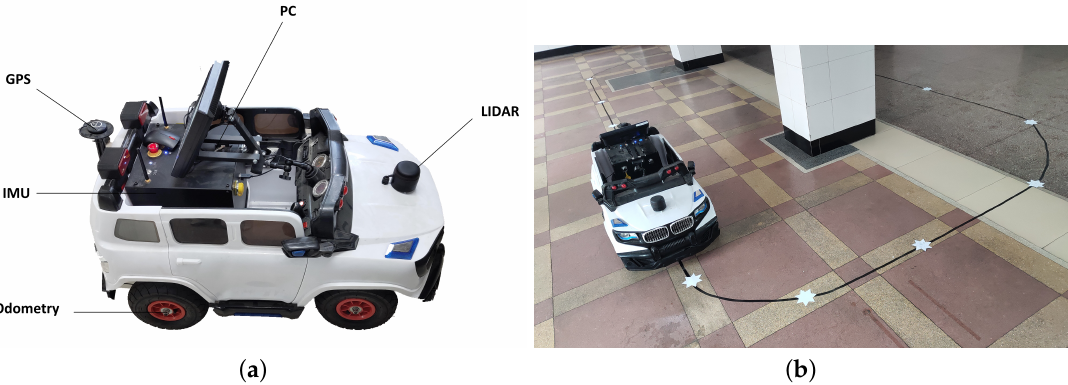
Figure 11. Field experiment condition. ( a ) Mobile robot used in the field experiment. ( b ) Field experimental